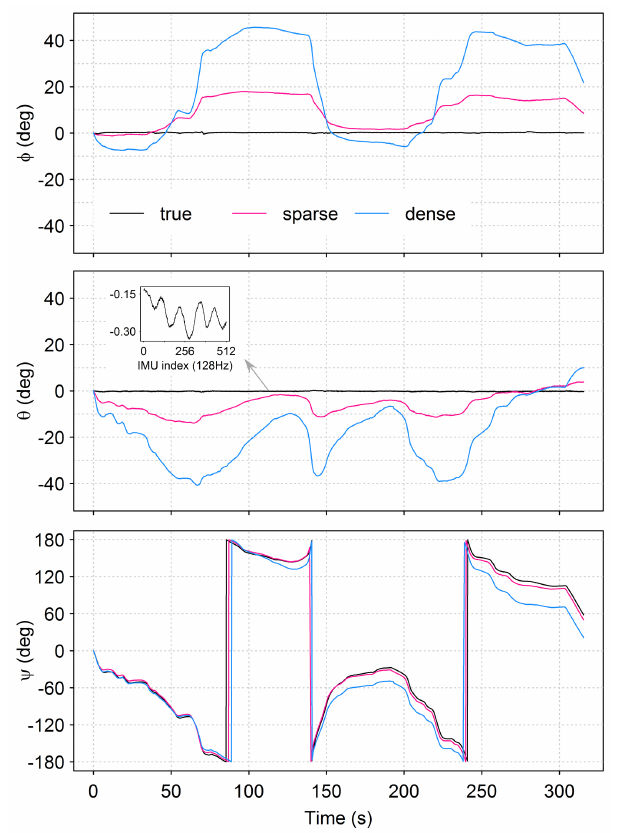
Figure 7. Camera orientation estimates in Euler angles for a discharge measurement track of four consecutive river crossings; φ , θ and ψ stand for pitch, roll and yaw,